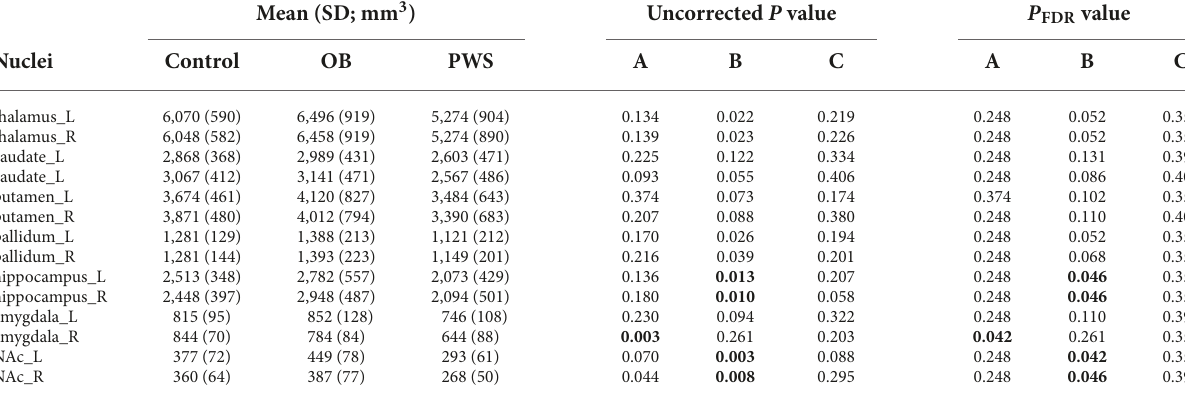
TABLE 2 Cerebral nuclei volumes of each group and P value of group